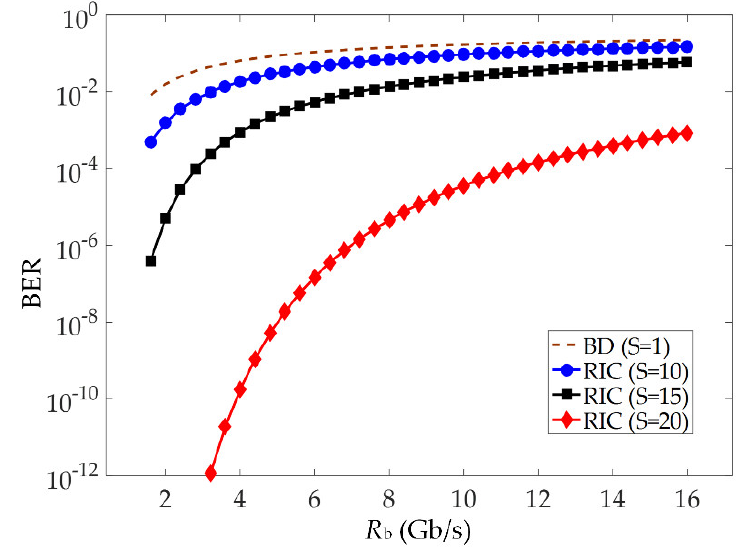
Figure 8. Bit-error rate (BER) versus the transmission data rate.